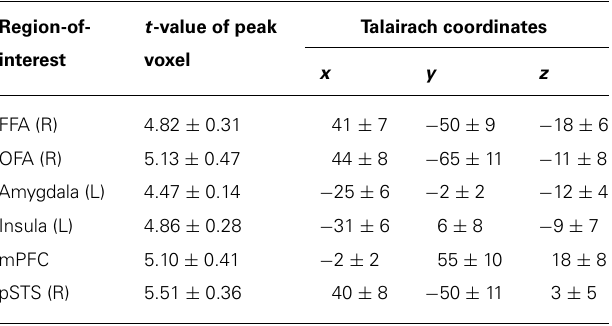
Table 2 |The ROIs defined by the functional localizer task of facial emotion perception. Region-of-